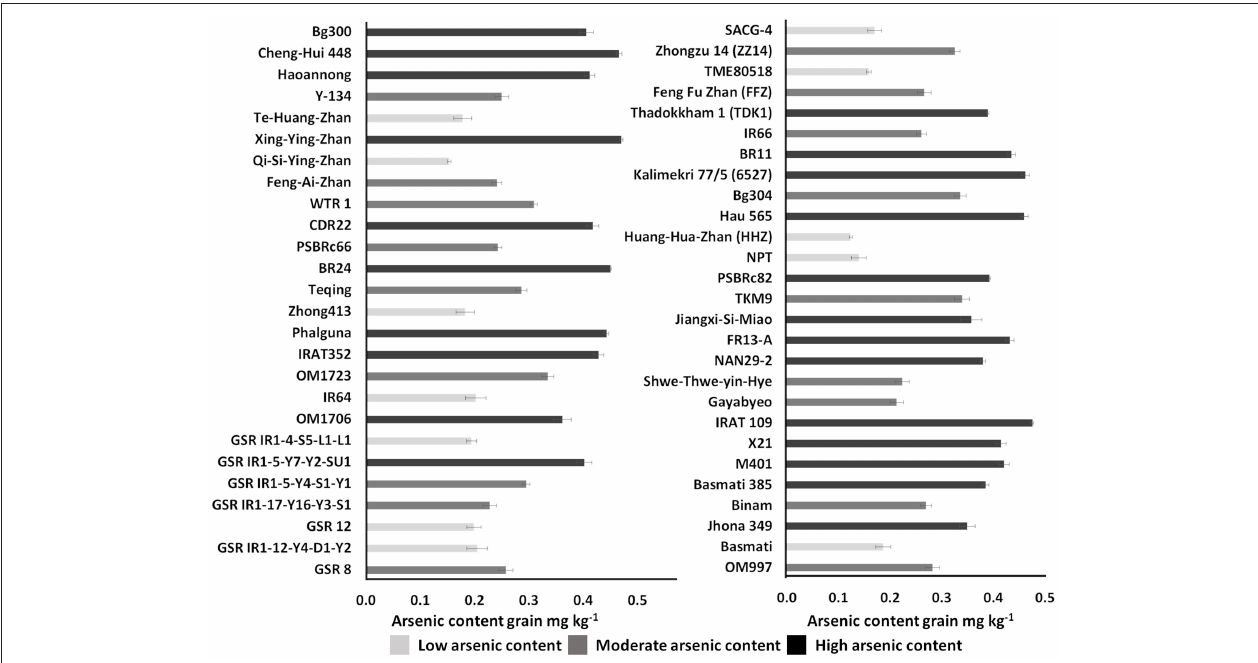
FIGURE 4 | Classification of diverse rice genotypes based on arsenic content in unpolished brown rice. Error bar in the graph represents a standard error ( n = 3); mg kg − 1 , milligrams per kilogram.